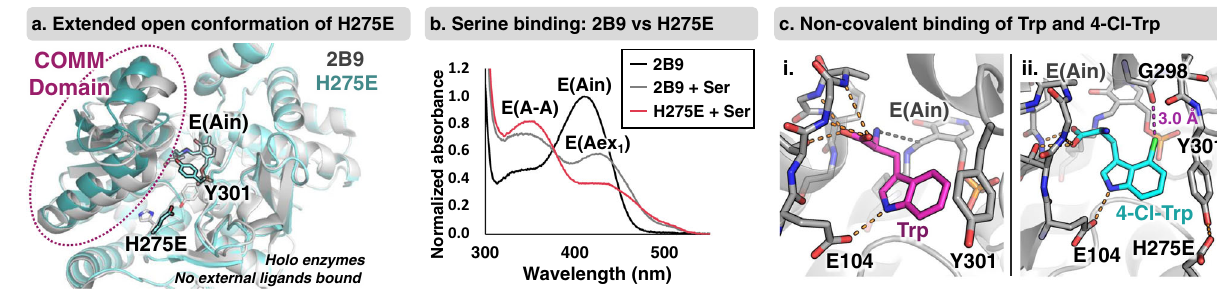
Fig.5|CrystallographicandspectroscopiccharacterizationofH275E.a Internal aldimine structure of H275E (light blue, PDB: 7RNQ) is superimposed with the corresponding structure of 2B9 (gray, PDB: 6AM7). b Addition of 20mM L -serine (Ser)to2B9(gray),resultsintwopeakscorrespondingtoexternalaldimineE(Aex 1 ) and amino acrylate, E(A-A), intermediates. Addition of 20mM Ser to H275E (pink)